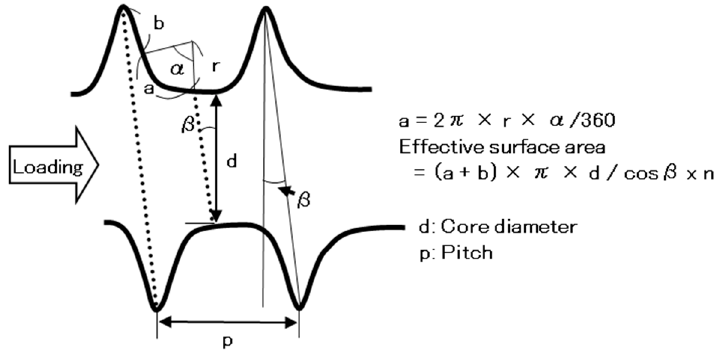
Figure 10. Schematic illustration of effective surface area of the screw.